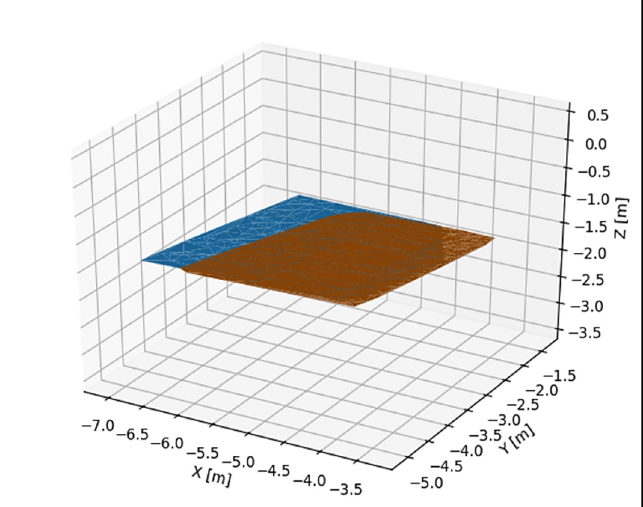
Figure 11. Asphalt road (Msplit fitting Figure 11 . Asphalt road (Msplit fitting result). Figure 11 . Asphalt road (Msplit fitting result).